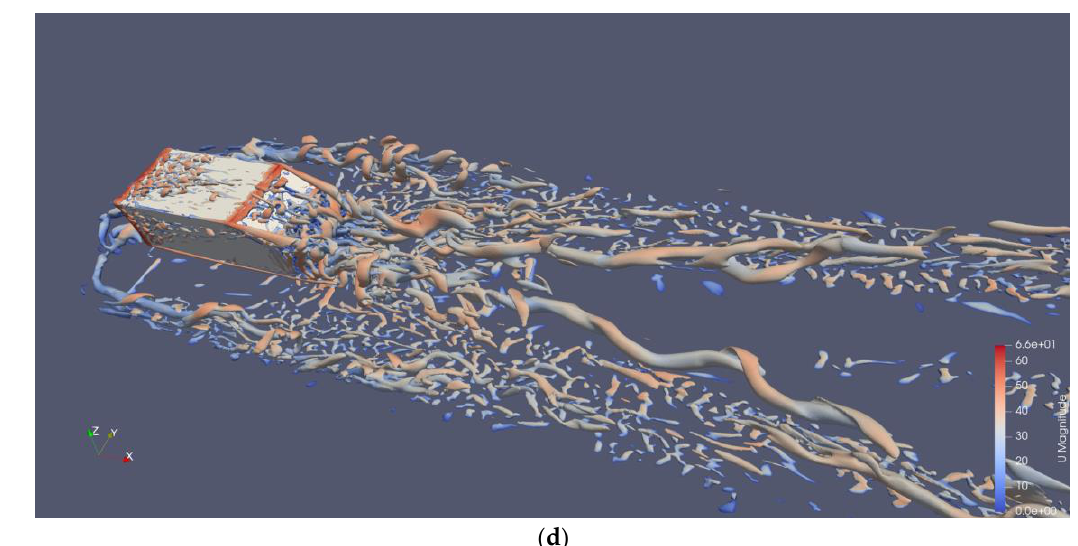
Figure 13. The development of vorticity around the Ahmed body by URANS and VLES models. ( a ) URANS: top view; ( b ) URANS: 3D perspective; ( c ) VLES: top view; ( d ) VLES: 3D perspective view.